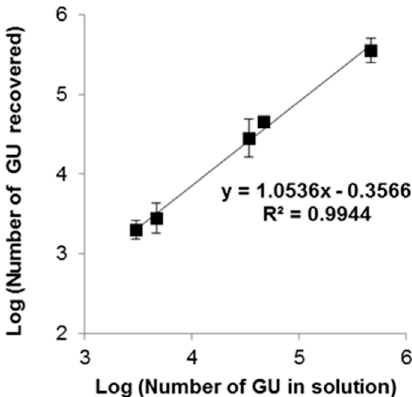
Figure 3. Assessment of the method’s linearity. Curves represent the log of the expected number of GU in the solution as a function of the number of GU recovered after extraction. Error bars represent the standard deviation for n = 3.